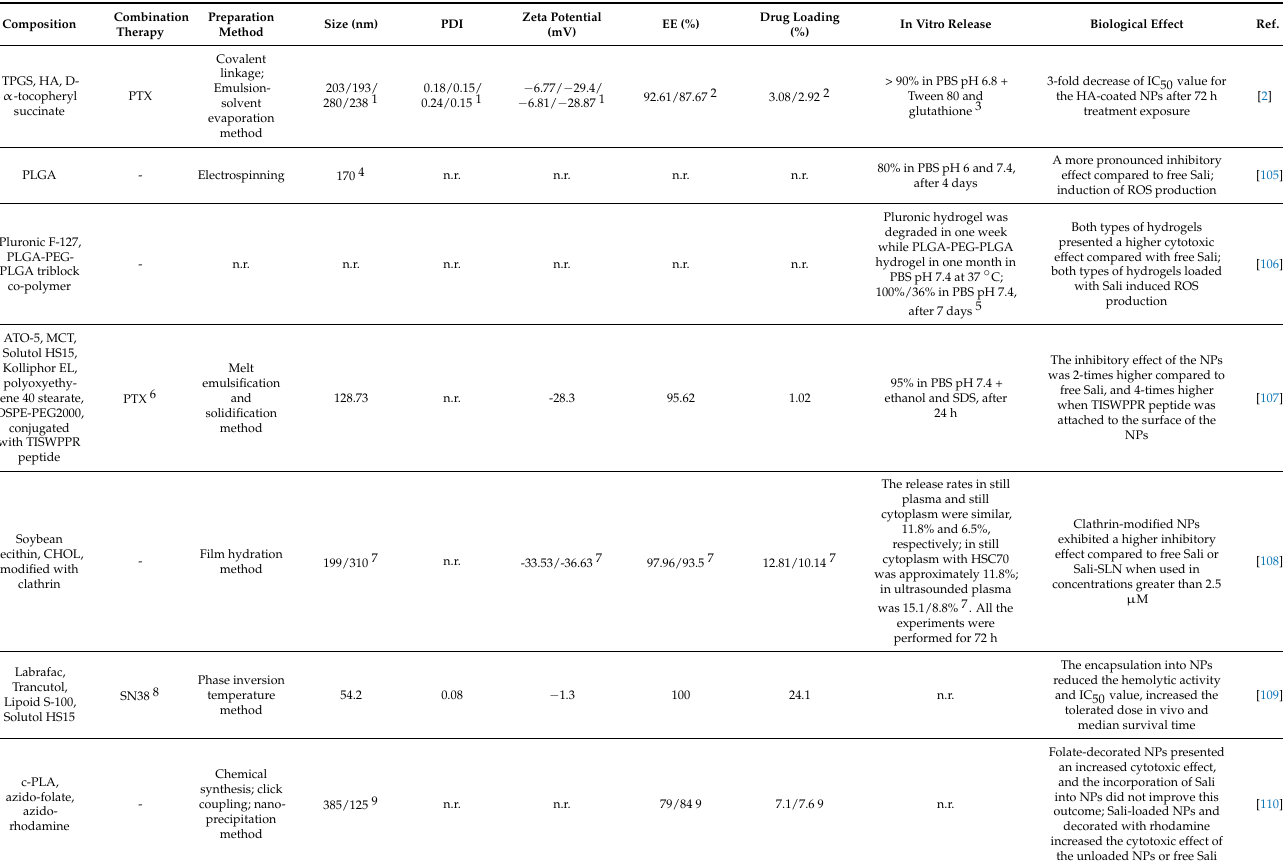
Table 9. Other types of nanoparticles loaded with